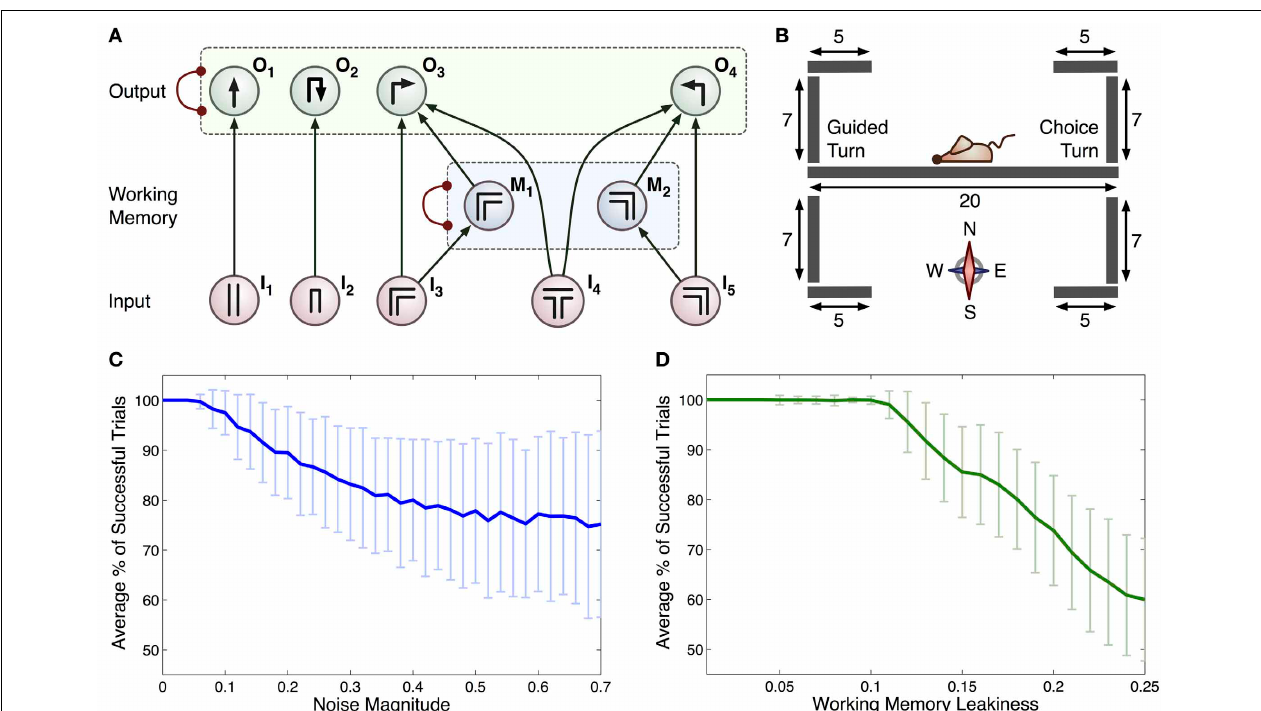
ahead, O 2 turnaround, O 3 rightturnand O 4 leftturn.The M 1 and M 2 integrators actasaworkingmemory. (B) Geometryofthe2Dvirtualenvironmentmadeup of 9 separate line segments. Initial position and orientation of the rat is shown. (C) Average % of successful trials with c (standard deviation as overall noise of all integrators) varied. (D) Average % of successful trials with standard deviation as leakiness of working memory integrators, k, is